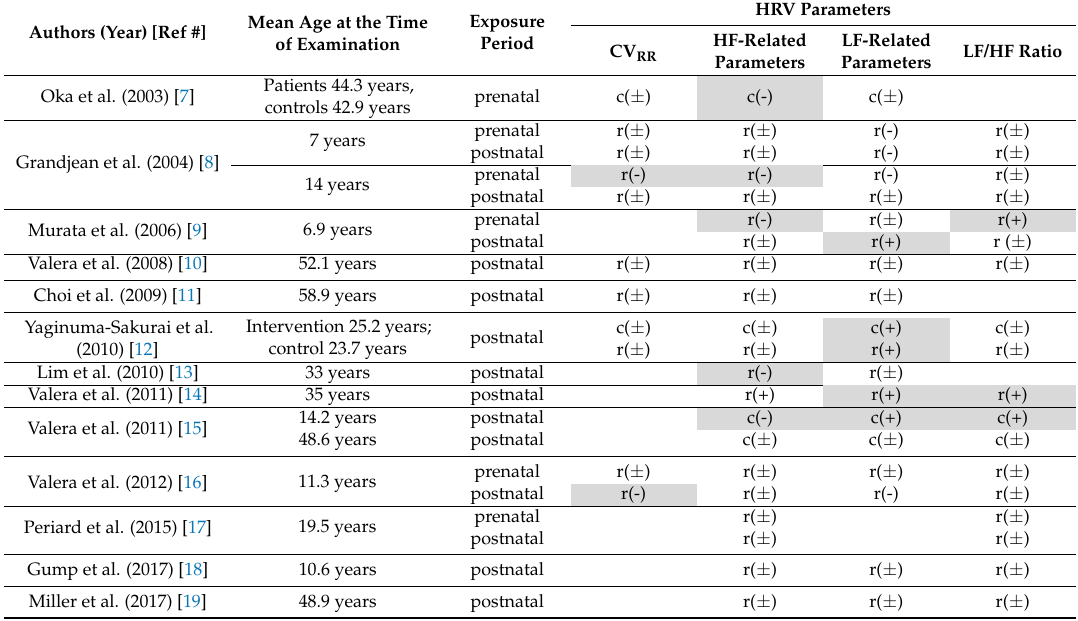
Table 2. Summary of associations between mercury levels and heart rate variability (HRV)